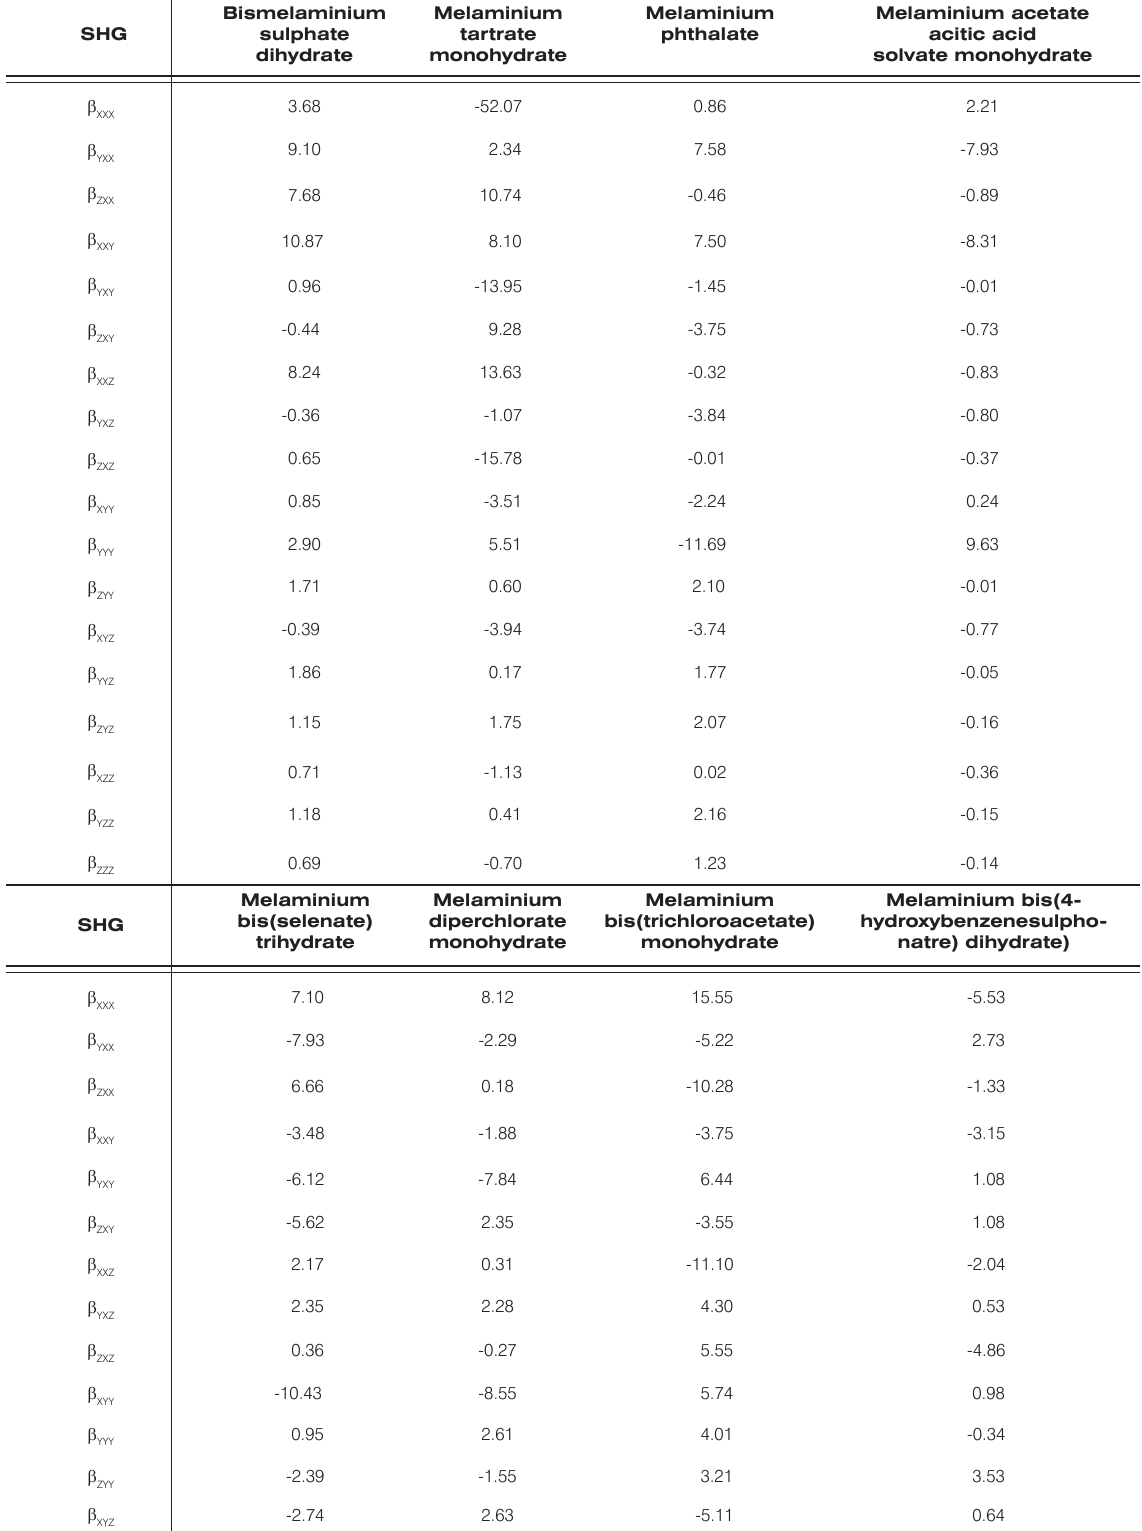
Table 3. The calculated hyperpolarizability b (unit of b is 10 -30 esu) and its directional properties for investigated molecules.